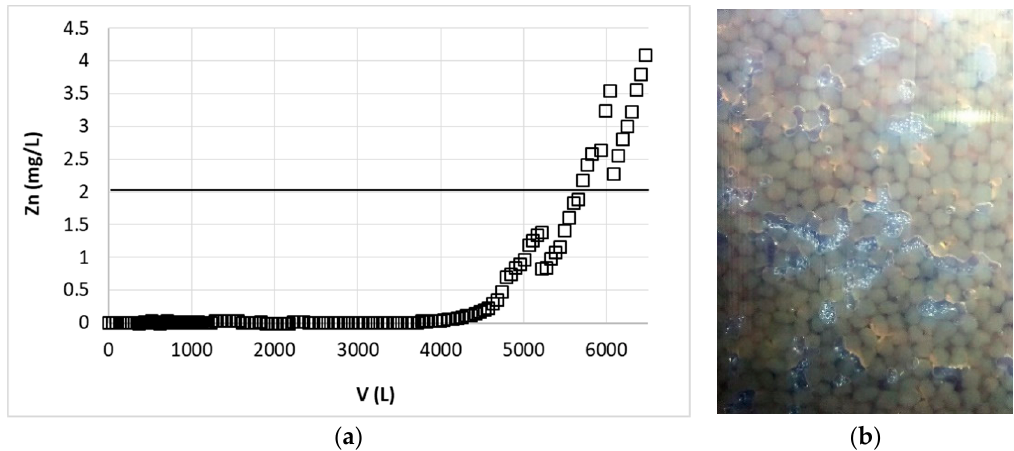
Figure 10. ( a ) Effect of zinc(II) ions removal on hybrid pectin-based biosorbent in the presence of air bubbles in the column. Flow rate: 45 L/h, mass of sorbent (dry form, large grain): 16 kg; initial concentration of Zn: 30 mg/L; pH = 6. ( b ) the air bubbles in the column.